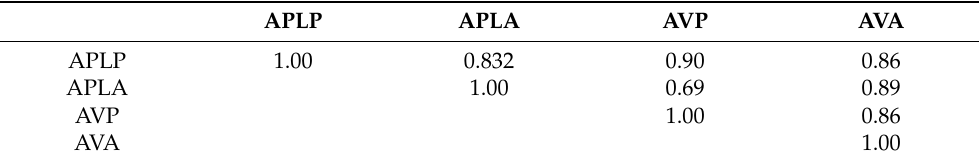
Table 2. Correlation results for both directions (33 subjects).